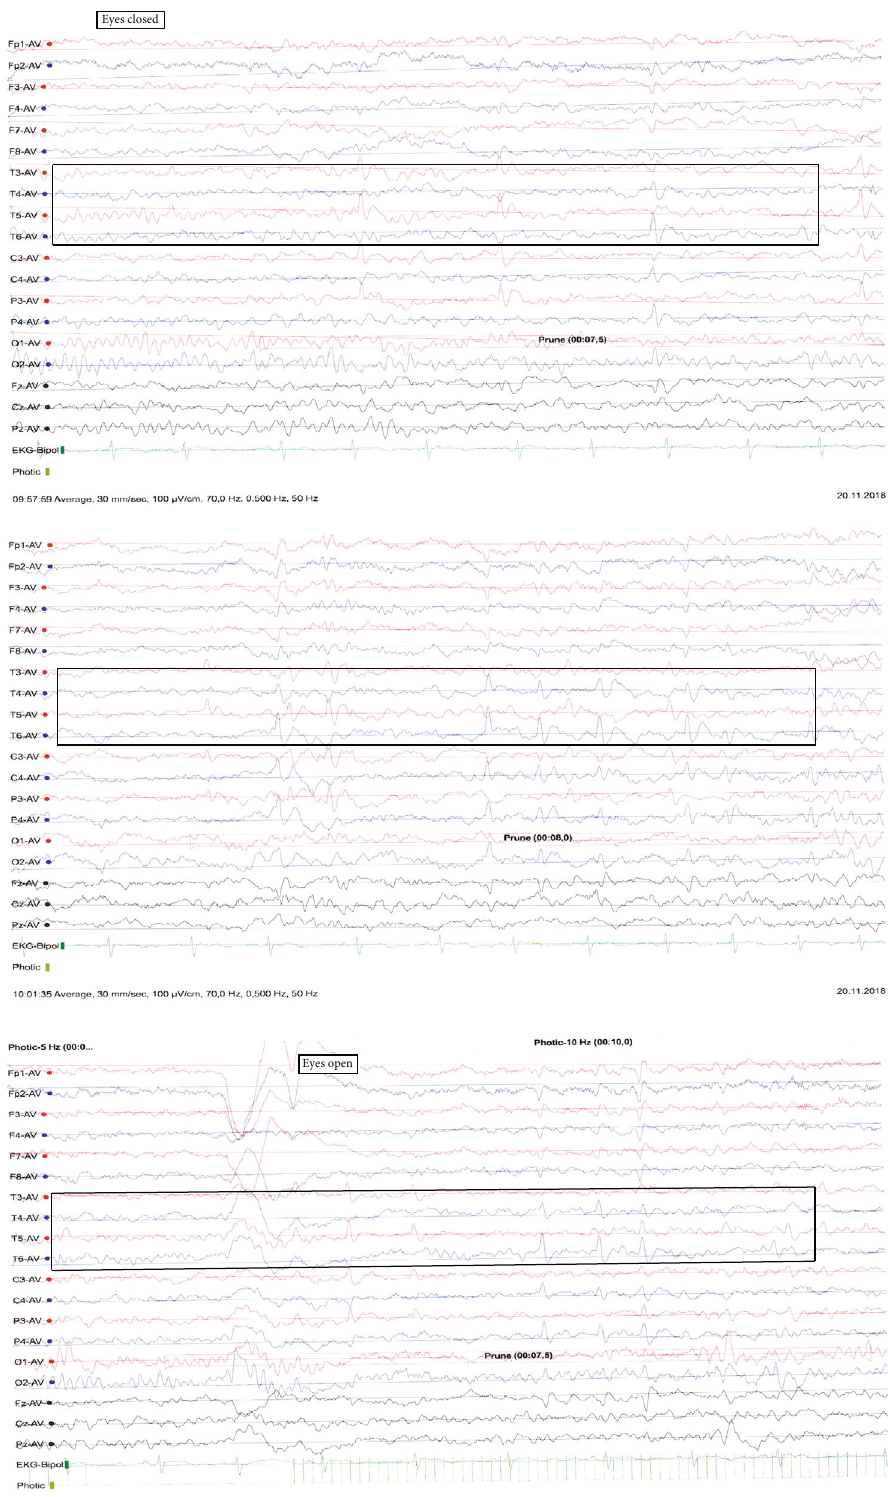
Figure 1: The EEG shows pathological activity with bilatero-temporal to central epileptiform activity, not